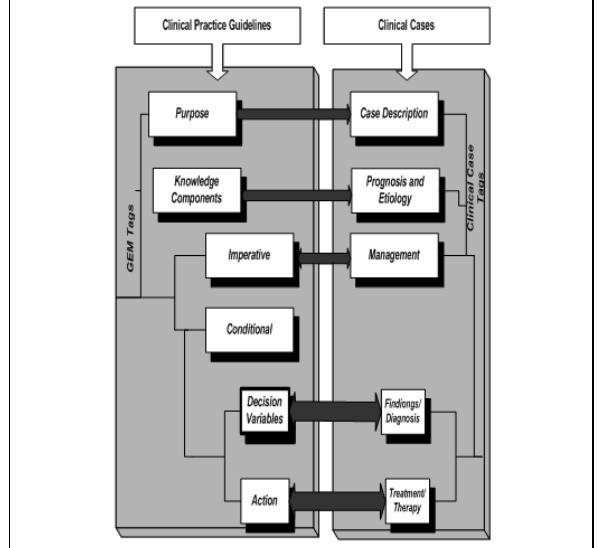
Figure 2: Conceptual Mapping of GEM-CPG and XML- CC